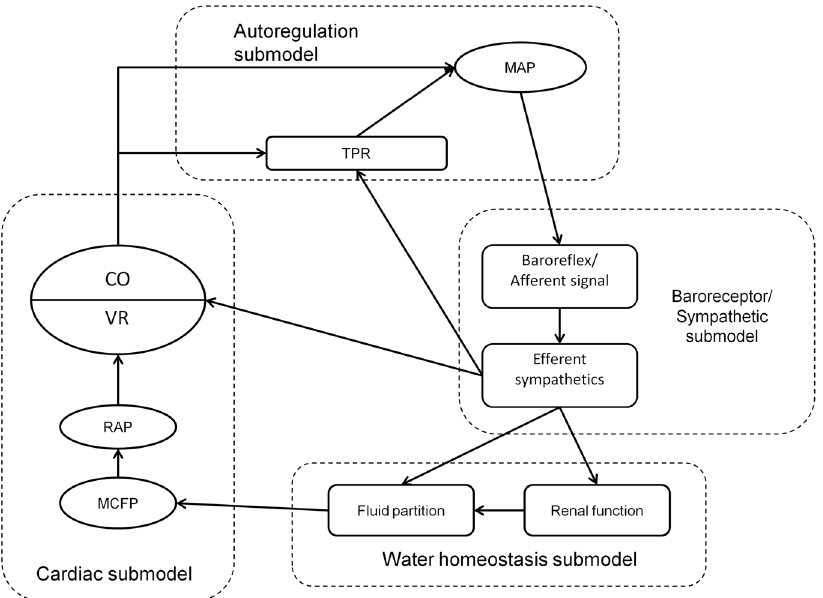
Figure 1. Schematic of interactions between the submodels. Ovals represent model variables, and rounded dashed boxes the submodels. The unlabeled submodel (light dashed line) is the cardiac integration model.